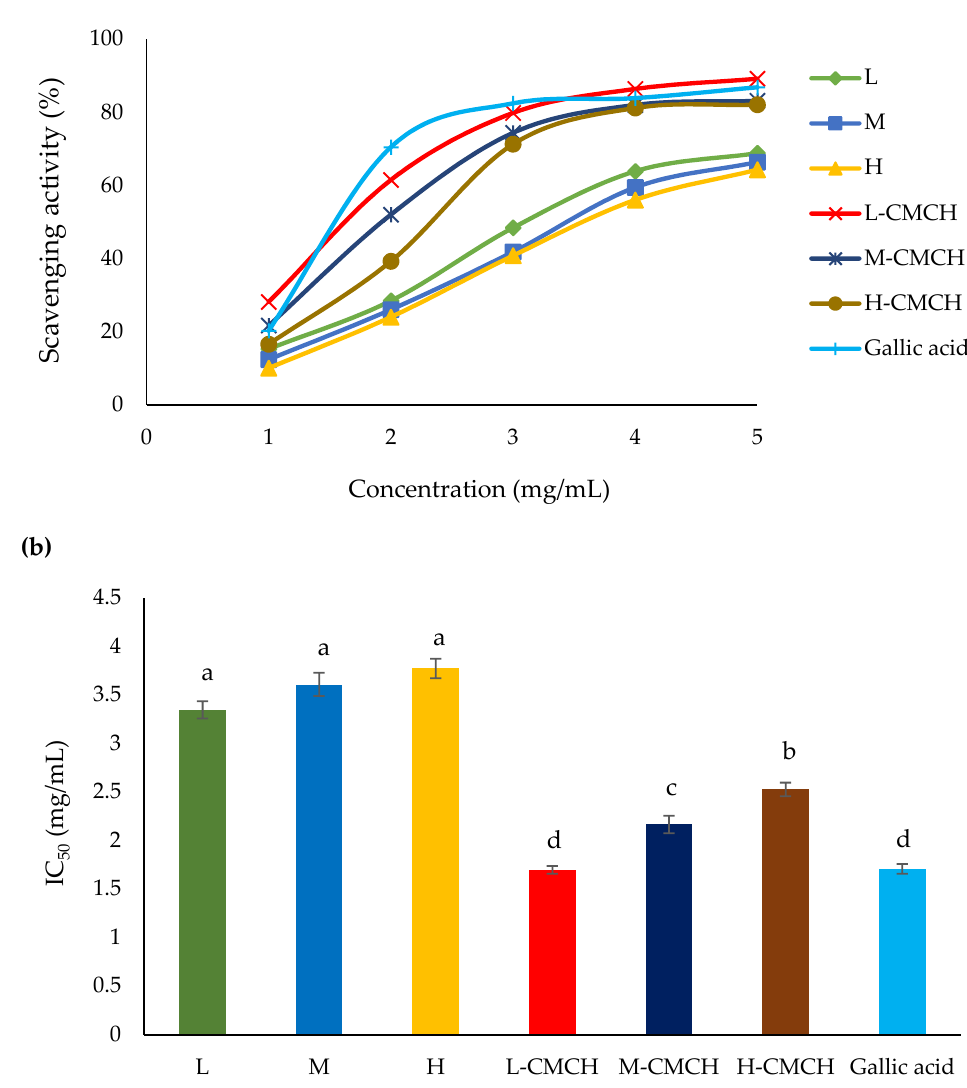
Figure 2. ( a ) DPPH radical scavenging activity (%) and ( b ) IC 50 of L, M, H, L-CMCH, M-CMCH and H-CMCH. Different letters (a-d) indicate significant difference between treatments ( p ≤ 0.05).